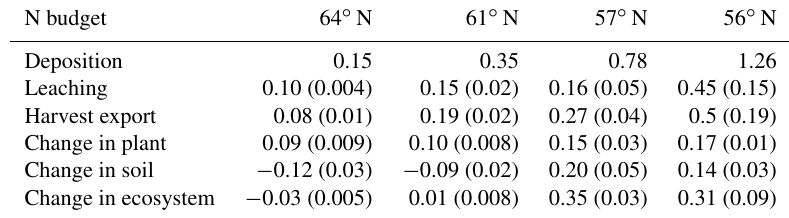
Table B2. Simulated annual N budget, including the associated uncertainty range (mean ± SD in gNm − 2 yr − 1 ).